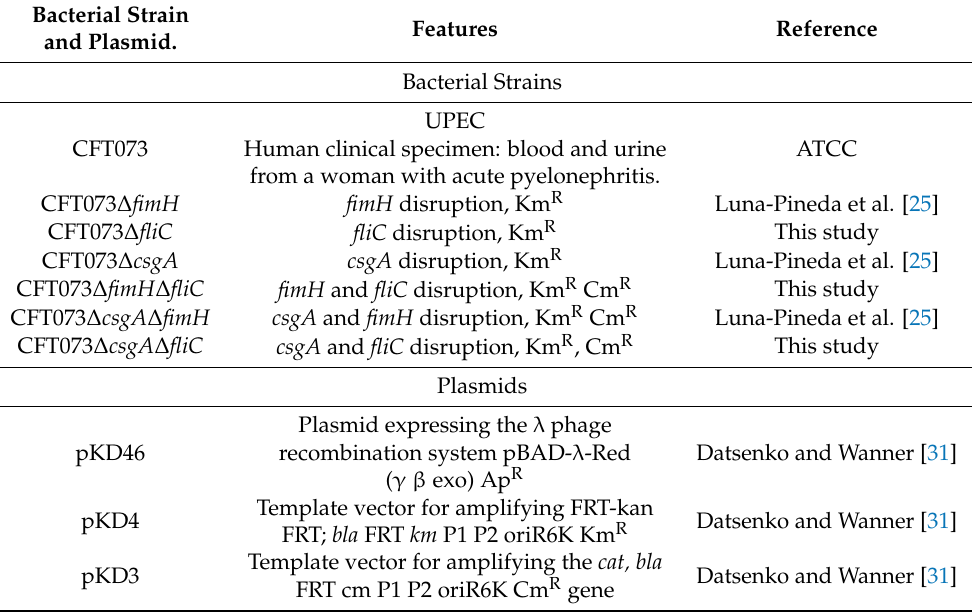
Table 1. The UPEC strains and plasmids used in this study. Bacterial Strain and